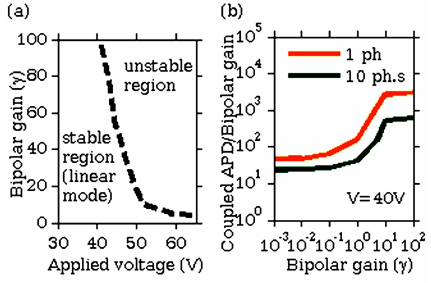
Figure 13: For a given applied bias, there exists a critical bipolar gain Υ , which separates the stable and unstable regimes (a). For )︁ (︁ , Q = µ 1 − µ 0 Q √ 2 σ 1 + σ 0 a given applied bias, there exists an optimal Υ to assure stable operation and produce the desired level of net gain combining the avalanche and bipolar gain mechanisms (b). From